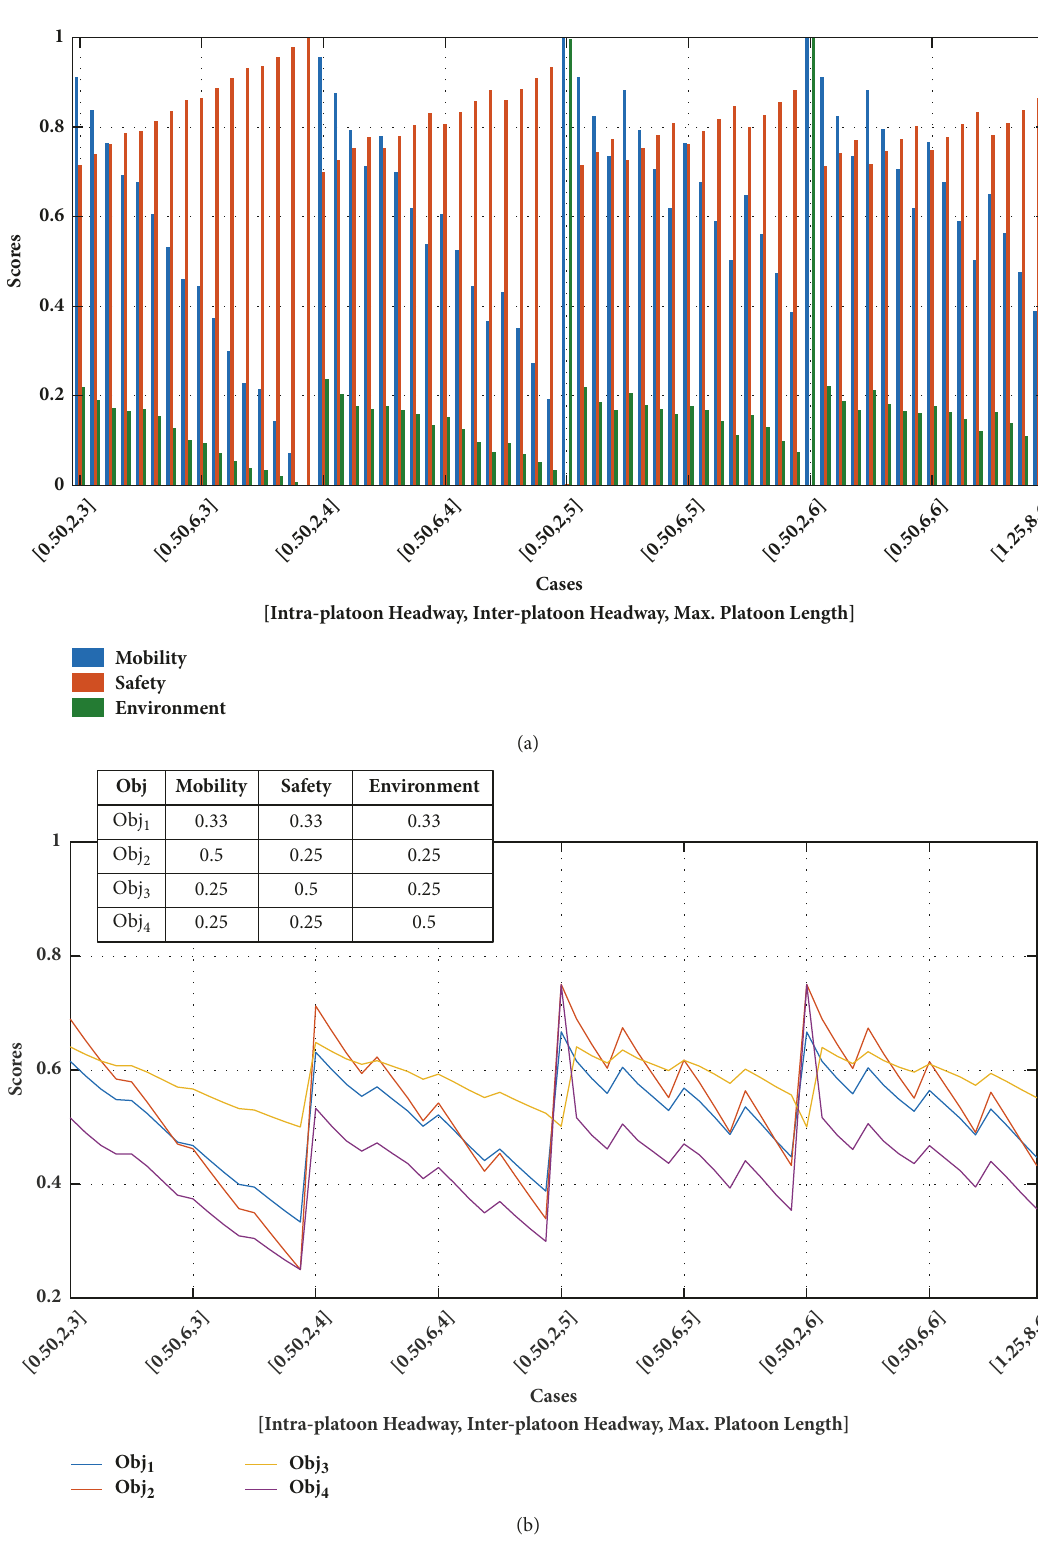
Figure 6: Observed variations of (a) individual features due to diverse platoon variables listed and (b) listed multiobjective function sets resulting from changing platoon